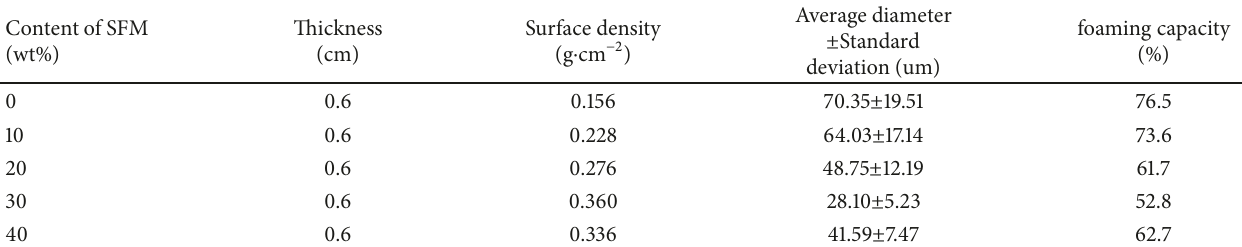
Table 2: Surface density, average diameter, and foaming capacity of SFM/NBR-PVC microcellular foaming